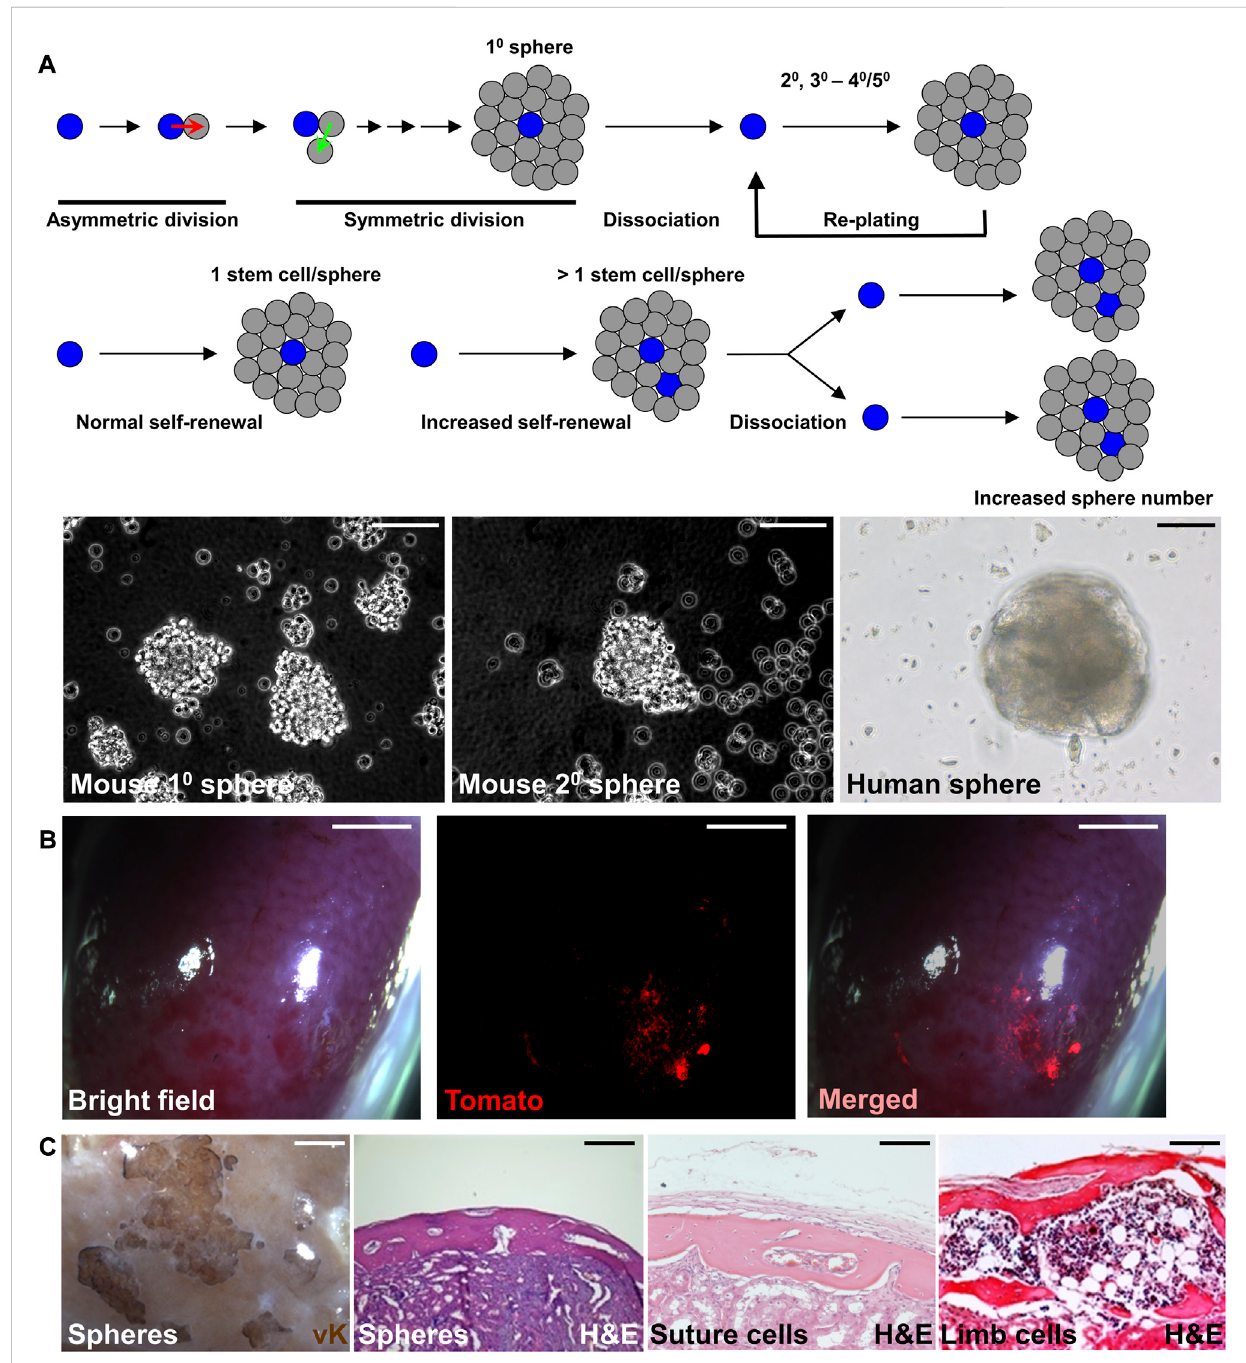
FIGURE 2 Preserving the stemness of SuSCs by sphere culture system. (A) Schematic representations illustrate the sphere culture of suture cells isolated from the calvarial suture mesenchyme in primary (1 0 ), followed by replating and subsequent culture for secondary (2 0 ), tertiary (3 0 ), and up to 4 0 – 5 0 passages. The representative image of mouse and human spheres in culture. (B) Wholemount imaging of kidney implanted with ex vivo cultured spheres derived from SuSCs positive for Tomato fl uorescence 4 weeks after renal capsule transplantation. (C) Representative images of the transplanted kidney evaluated byvon Kossa(vK)andhematoxylinand eosin(HandE)staining6 weeks afterthetransplantationoffreshlyisolated suturecells(Suturecells),or corticalcellsisolatedfromthelimb(Limbcells),or8 weeksafterthetransplantationofspheresformedbythecultureofsuturecells(Spheres).Notebones generated by spheres show identical features to those generated by freshly isolated cells. Scale bars, 50 μ m (A) ; 2 mm (B) ; 100 μ m (C)